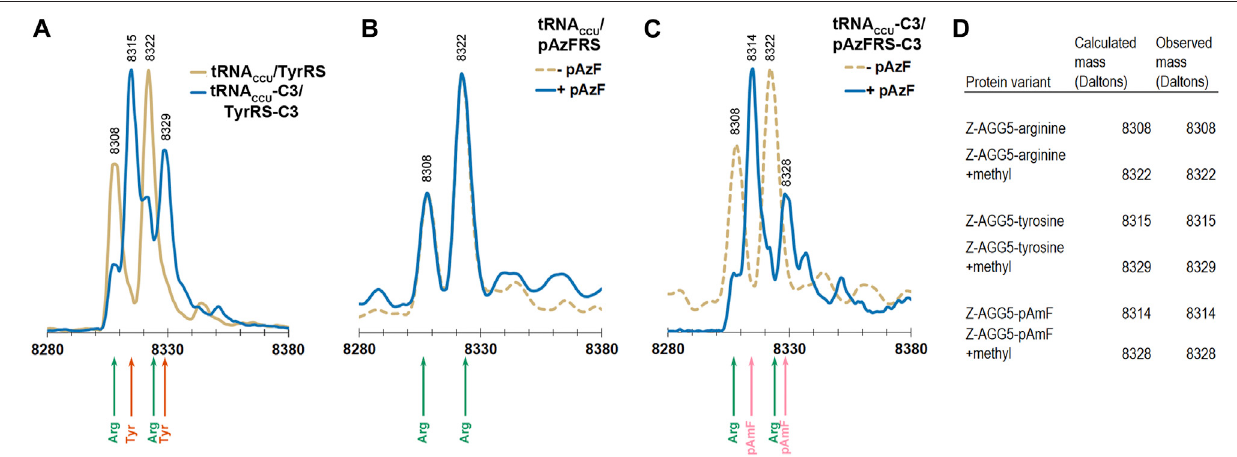
FIGURE 4 | ESI-MS of puri fi ed Z domain proteins for identi fi cation of amino acids incorporated in response to an AGG codon at position 5 in the gene. The expectedmassforincorporationofArginresponsetoAGGis8308 Da.Theexpected massforincorporation ofTyrinresponsetoAGGis8315 Da.Theexpectedmass for incorporation of reduced pAzF (pAmF) in response to AGG is 8314 Da. In all 3 instances, an additional mass at +14 Da relative to the parent mass is observed and likelycorrespondstomethylationoftheZdomain. (A) Massspectraforproteinsproducedusingthetyrosine-incorporating M.jannaschii tRNA CCU /TyrRSpair(gold line) and M. jannaschii tRNA CCU -C3/TyrRS-C3 (blue line) variants. In the case of the original M. jannaschii tRNA CCU /TyrRS pair, only peaks for arginine incorporation are apparent(8308, 8322 Da, green arrows). Peaks at 8315and 8329 Da(orangearrows) corresponding totyrosine incorporation inresponsetoAGG arereadily apparent in the Z domain expressed in the presence of the M. jannaschii tRNA CCU -C3/TyrRS-C3 variant. (B) Mass spectra for proteins produced using the para - azidophenylalanine-incorporating M. jannaschii tRNA CCU /pAzFRS machinery in the presence (blue line) and absence (gold dotted line) of ncAA. In both cases, incorporation of Arg in response to AGG is the only set of masses detected (green arrows). (C) Mass spectra for proteins produced using the para -azidophenylalanine- incorporating M. jannaschii tRNA CCU -C3/pAzFRS-C3 machinery in the presence (blue line) and absence (gold dotted line) of ncAA. Only in the presence of para - azidophenylalanineare peaks correspondingtoincorporationof ncAAobservedat 8314 and 8328 Da (pink arrows).In theabsenceofncAA,only arginineincorporation is detected (green arrows). (D) Table of calculated and observed masses (Daltons) for each